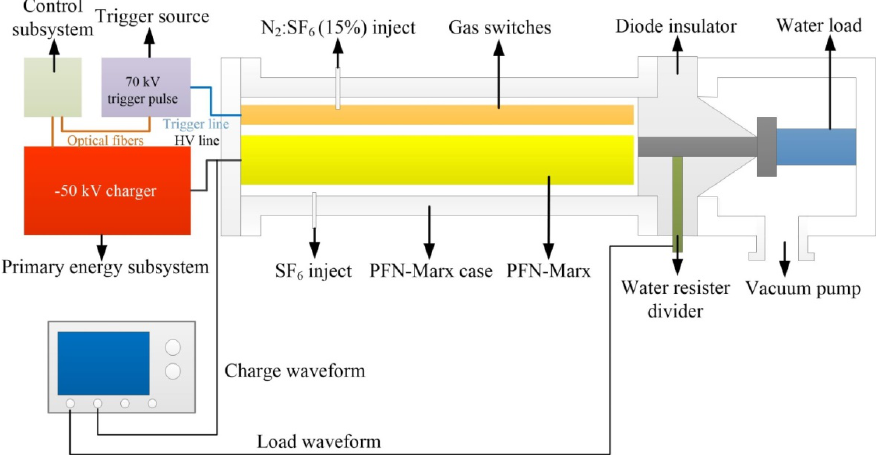
Figure 14. Schematic view of the PFN-Marx system.